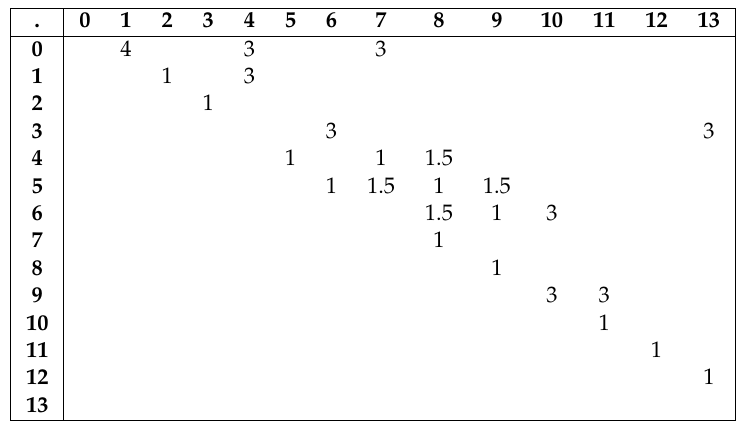
Table 1. The original distance matrix corresponding to the warehouse structure shown in Figure 1 containing only the values required by the